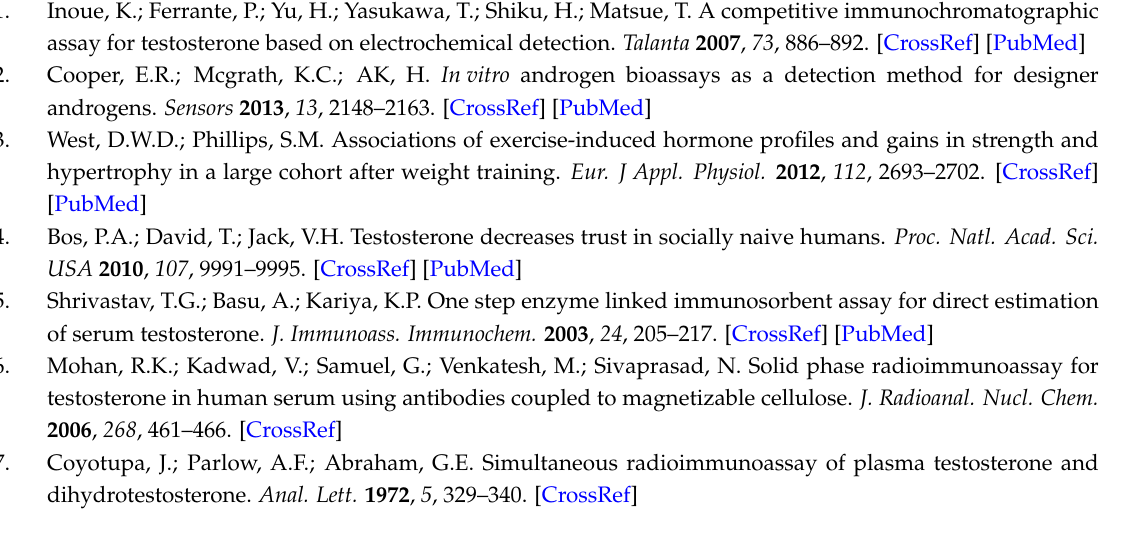
Figure 6. Resonant wavelength shift of the sensor for 1 ng/mL testosterone after each regeneration.